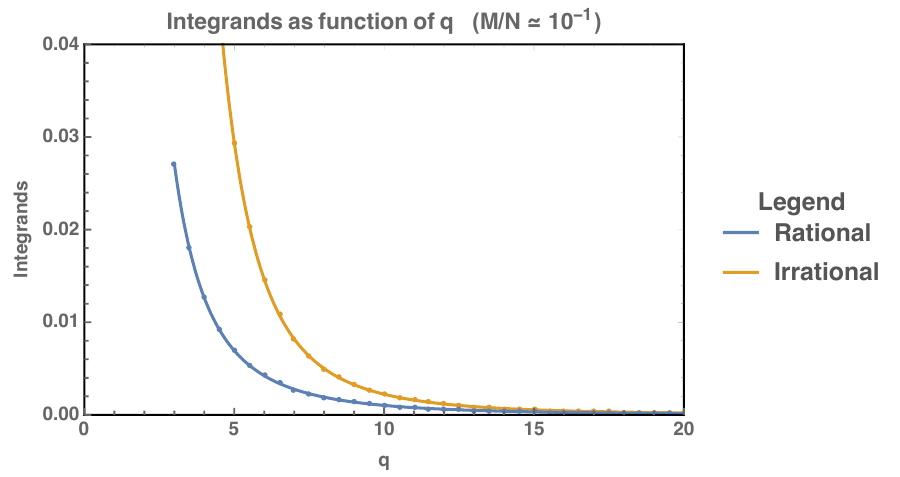
Figure 6. Here we show the integrands from eq. (4.5) for both branches. The dots indicate the numerical evaluation of these quantities, whilst the solid lines indicate the integrands with the (cid:12)tted (cid:1) behaviour of q . We only plot a subset of the computed q values for